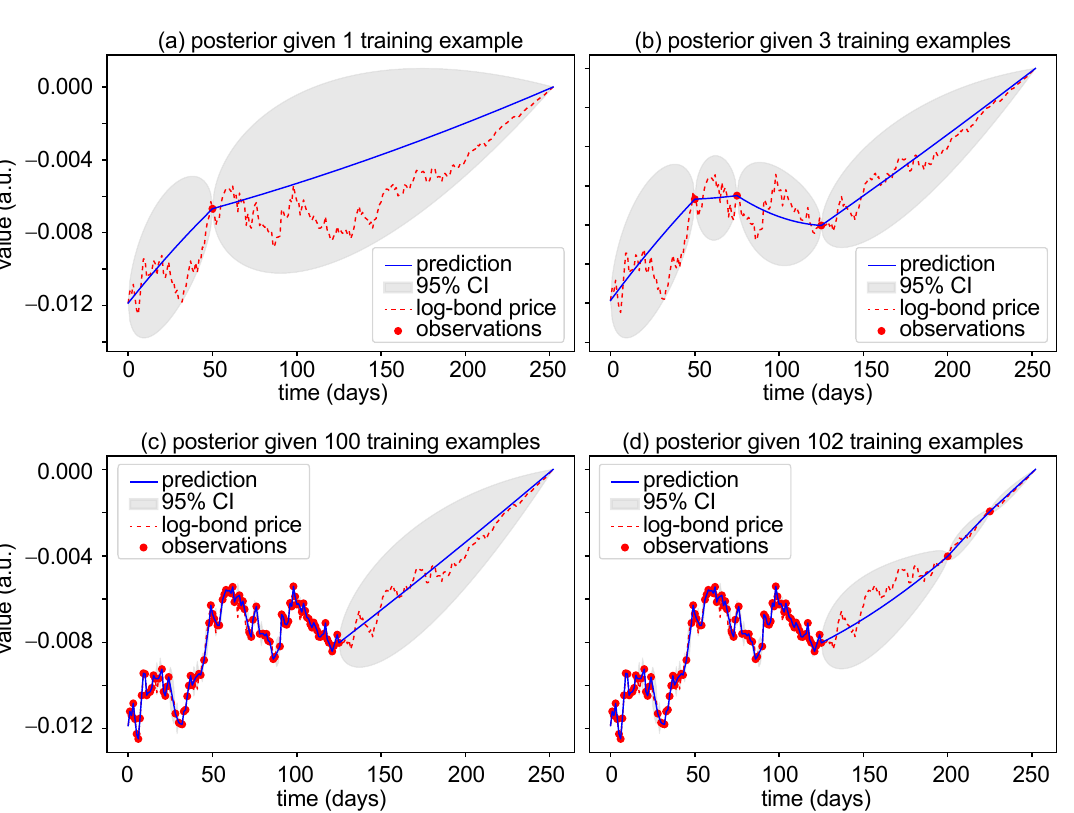
(d) posterior given 102 training examples(c) posterior given 100 training